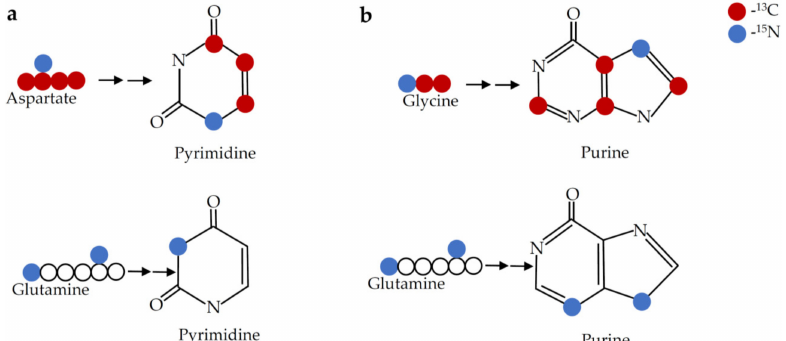
Figure 4. Carbon and nitrogen labelling of pyrimidine and purine rings. ( a ) When labeled with 1- 15 N, 4- 13 C- aspartate, three 13 C and one 15 N are incorporated into the pyrimidine ring, and when labeled with 2- 15 N- glutamine, one 15 N is incorporated into the pyrimidine ring. ( b ) When labeled with 1- 15 N, 2- 13 C- glycine, up to four 13 C and one 15 N are incorporated into the purine ring, and when labeled with 2- 15 N- glutamine, two 15 N are incorporated into the purine ring. 13 C and 15 N are represented with red and blue dots